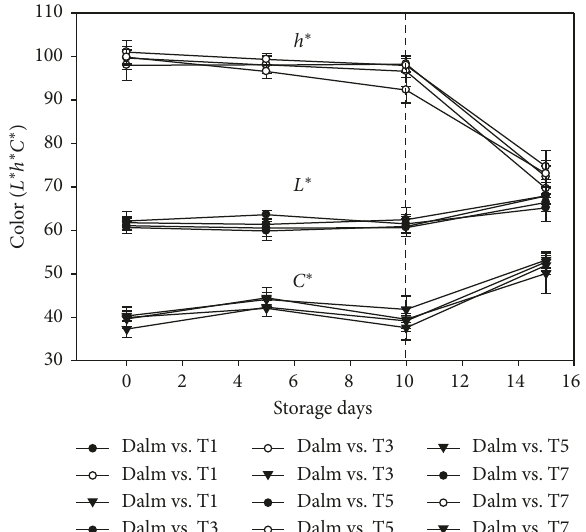
Figure 3: Stenospermocarpic mango “Ataulfo” fruit coated with 2% starch. T1 (banana “Pear”), T3 (soursop), T5 and T6 (mango “Ataulfo”), and T7 (control fruit: uncoated). Fruit stored at 10 22 2 ° ± (44.77 and 54.65, respectively) in 5 days and 51.58 and 54.28 in the final period.